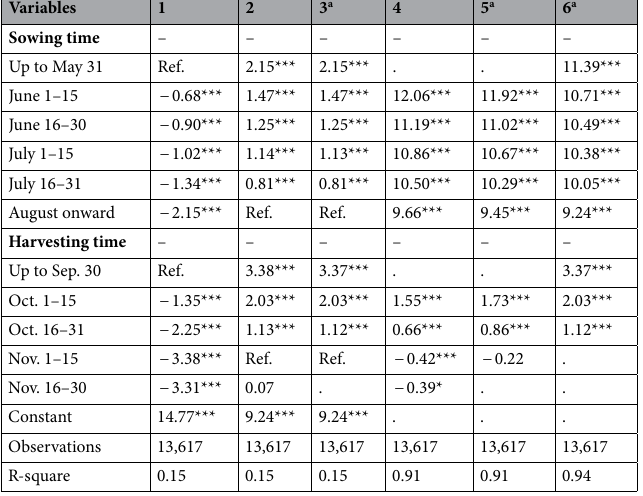
Table 4. Sowing and harvesting time impact on rice yield in the Punjab. ***p < 0.01, *p < 0.1. a Robust standard